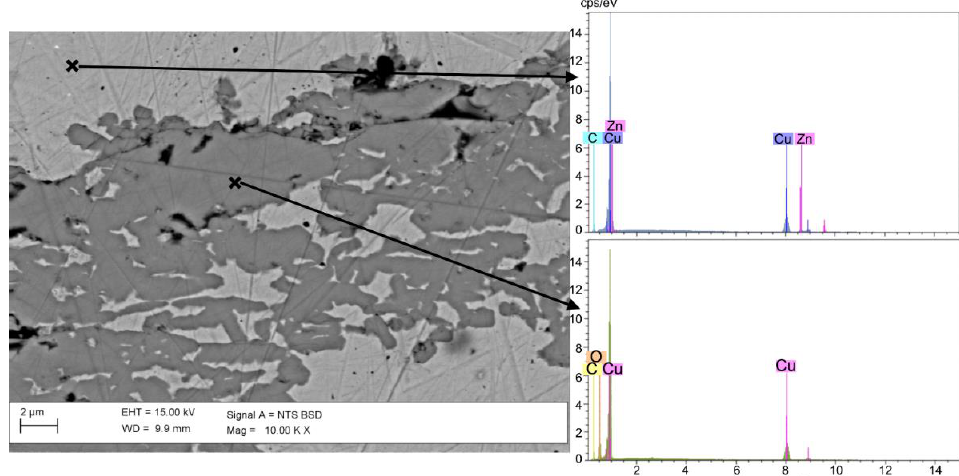
Figure 4. BSE image at sub-micro scale of cross section of sample F1 and related EDS spectra of unaltered and altered areas. It can be seen that in degraded areas zinc is totally absent and dezincification has completely occurred.